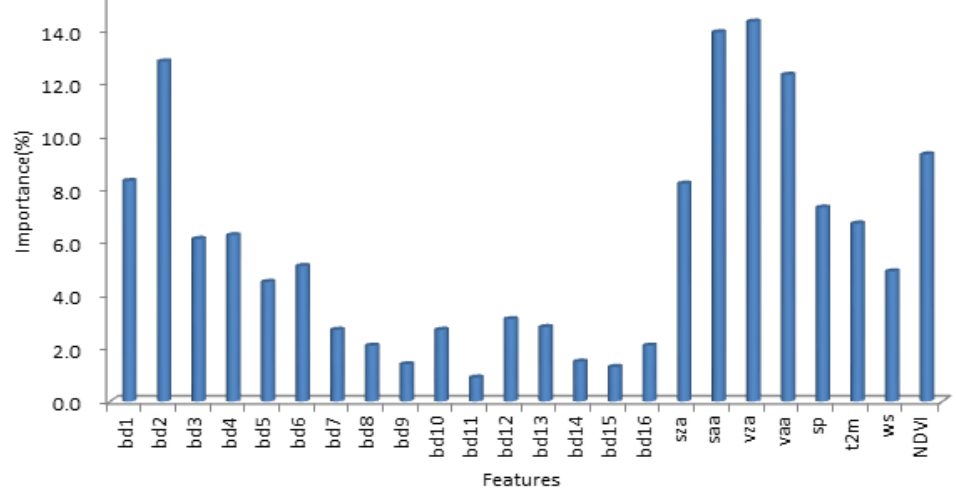
Figure 3. Himawari-8/AHI aerosol retrieval importance of input features calculated by the PCC